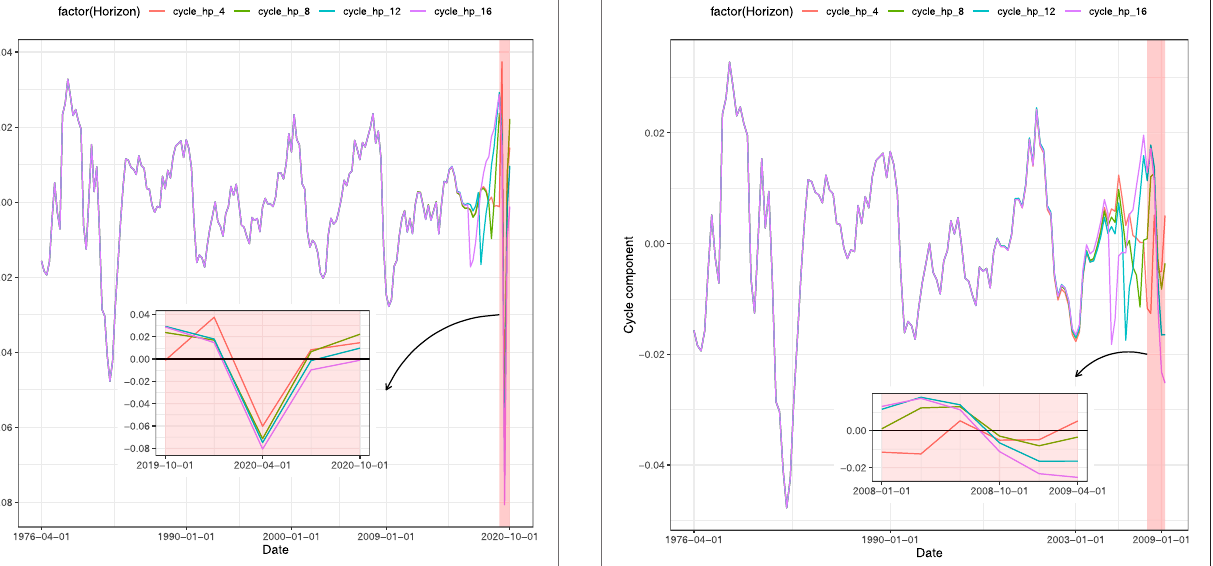
FIGURE 2 | Cycle decomposition of GDP, sensitiveness to different horizons until second quarter of